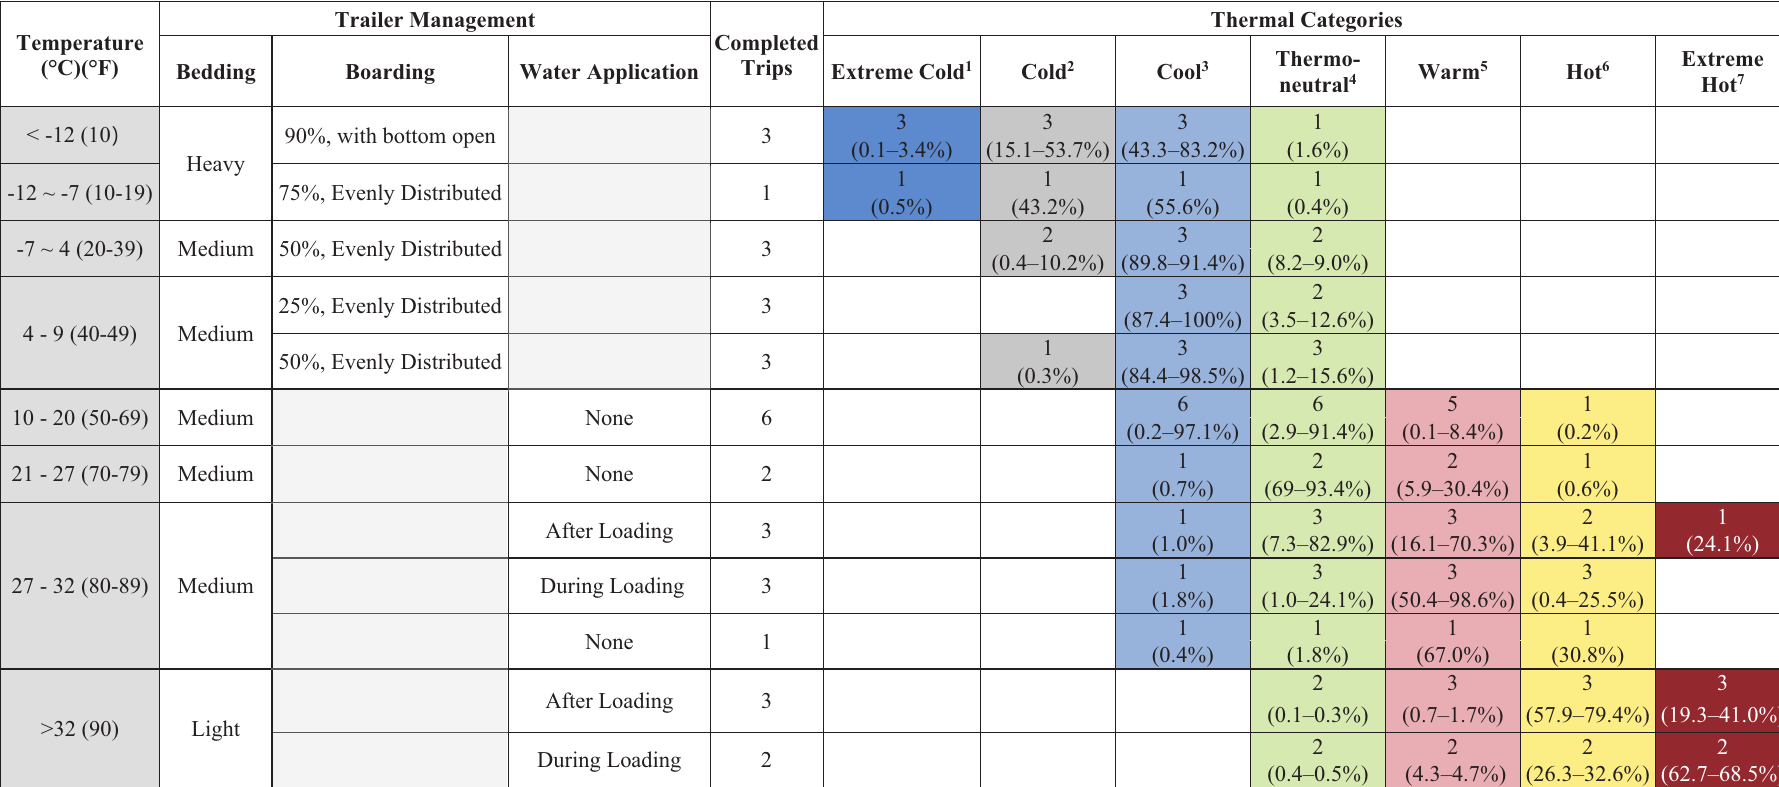
Table 5. Assessment of trailer environment based on categorizing all 84 pig-level air temperature measurements and their locations into thermal comfort classifications for all transport durations with pigs on the trailer. Data include 33 monitoring trips during hot, mild and cold outdoor conditions. A colored block indicates that the condition occurred at some point during one of the trips monitored. The top number inside the colored block indicates the number of trips experiencing this condition. A single trip may experience multiple ranges of thermal conditions. The bottom number represents the percentage of duration for that condition, with the range covering all trips for the given